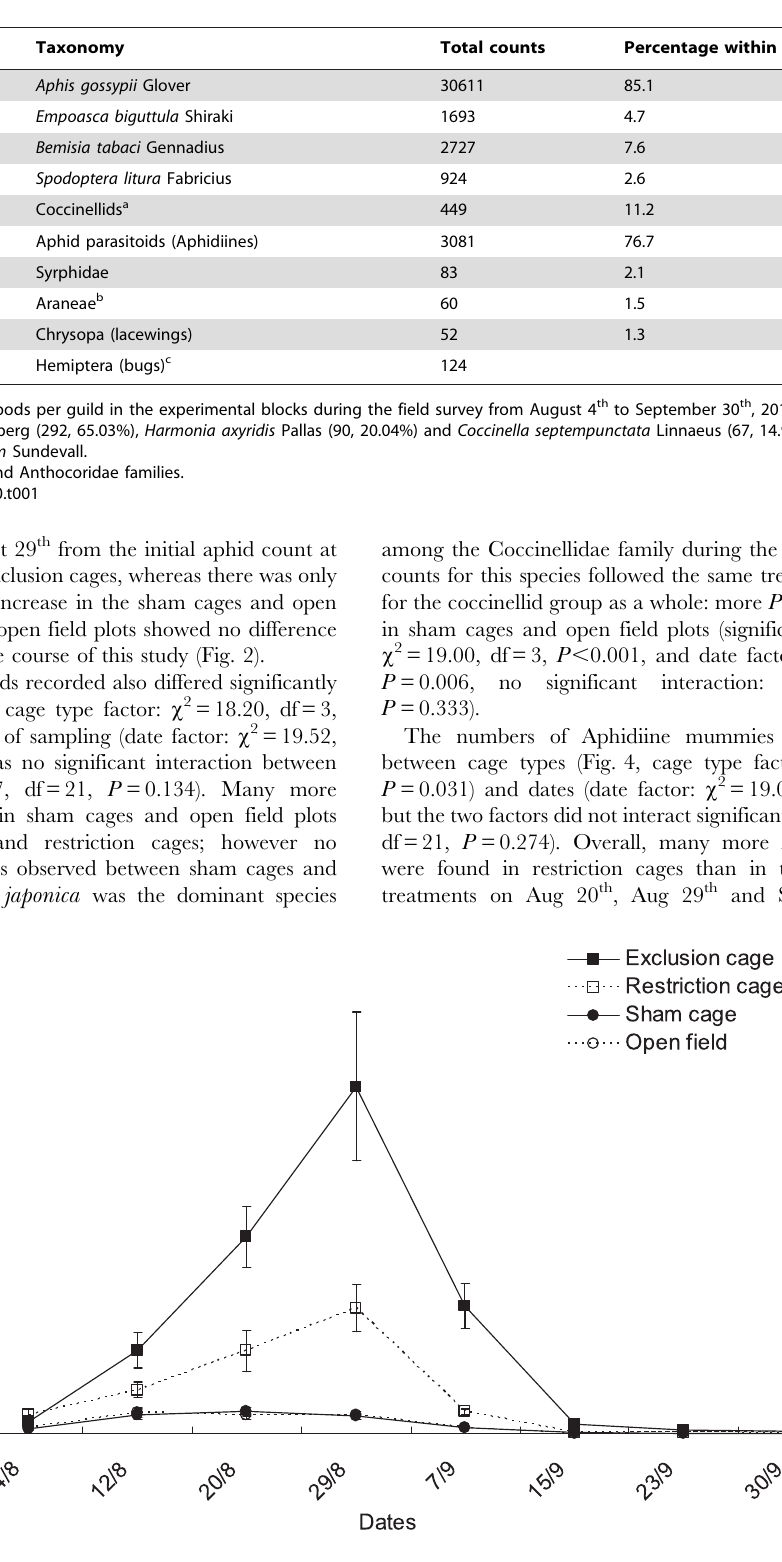
Figure 2. Cotton aphid population dynamics. Mean numbers ( 6 SEM) of A. gossypii per plot in the various natural enemy exclusion treatments from early August to end of September in Bt cotton in Ezhou